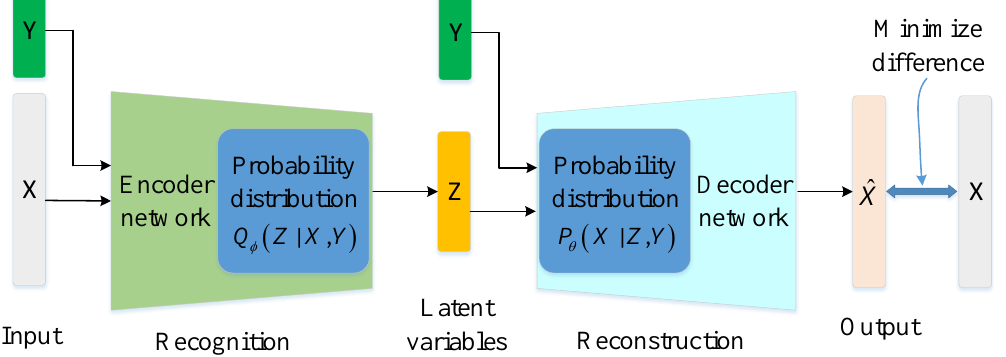
Figure 2. Conditional variational AutoEncoder (CVAE) architecture.